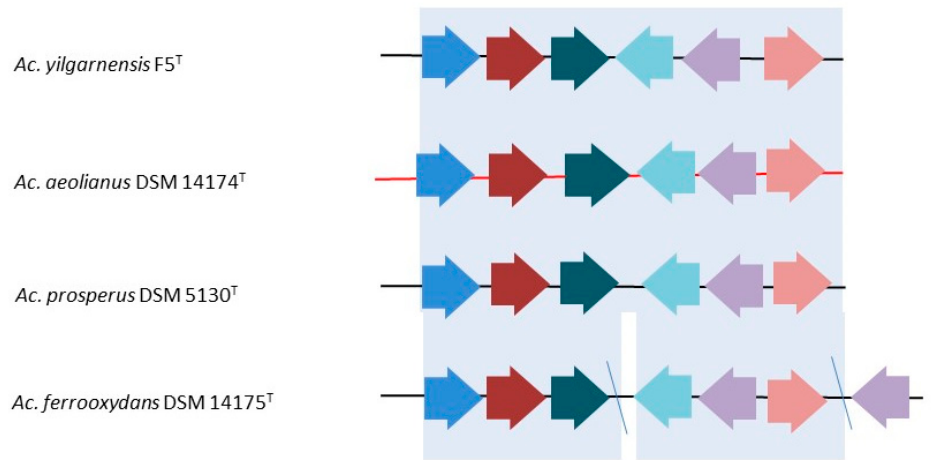
Figure 2. Genetic organization of the ppx and ppk genes in the four species of Acidihalobacter . Blue arrows = phosphate regulon transcriptional regulatory protein (PhoB); brown arrows = phosphate regulon sensor protein (PhoR); green arrows = exopolyphosphatase (EC 3.6.1.11) (Ppx); light blue arrows = lipoprotein, putative (Lipo); light purple arrows = polyphosphate kinase (Ppk); pink arrows = phosphate transport system regulatory protein (PhoU). Blue lines indicate that the genes are not contiguous. Red line indicates reverse orientation.